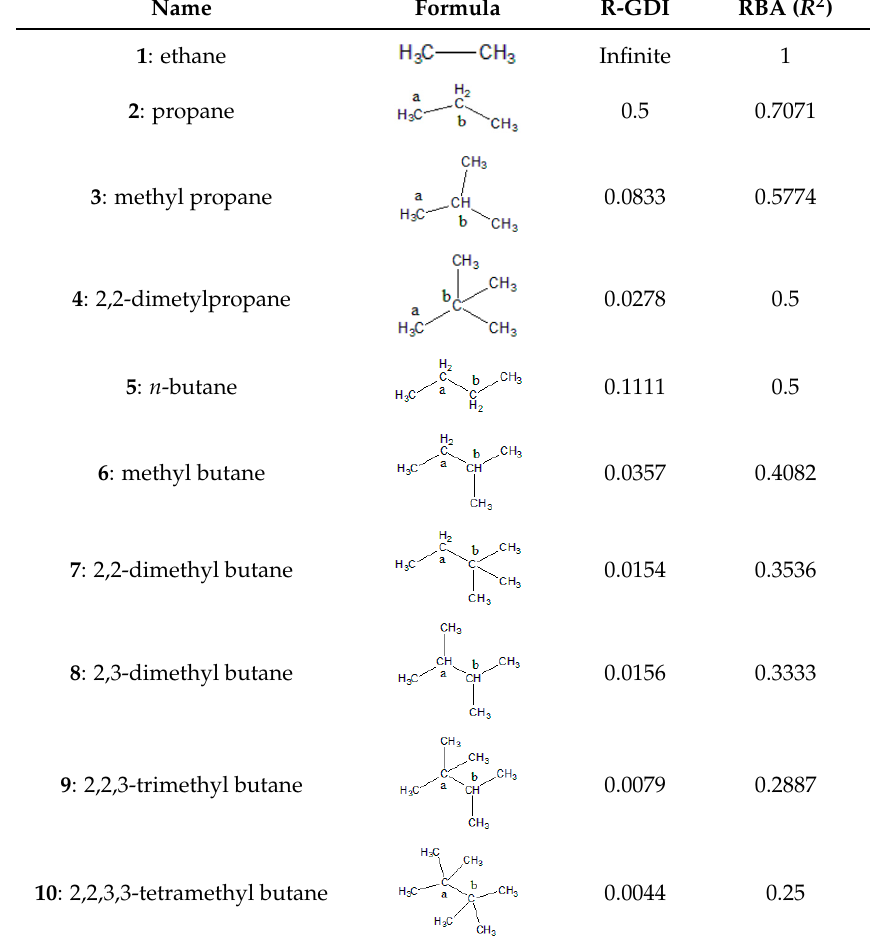
Table 8. Accessibility to the chemical bond (Connectivity Indices and Graph Derivative Indices (GDIs)).